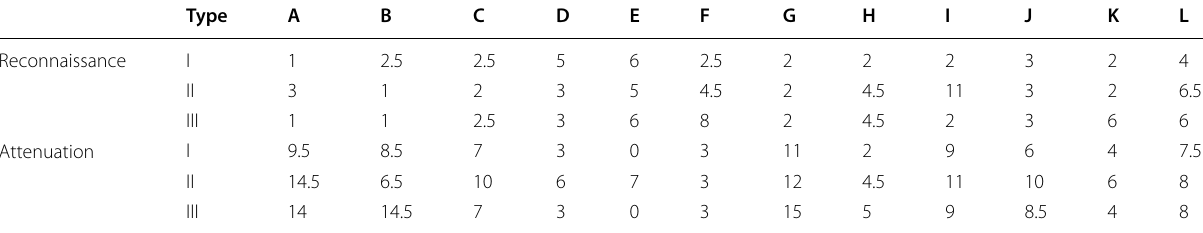
Table 16 Order of the evaluation items during the reconnaissance and attenuation activities was evaluated by the Levenshtein distance